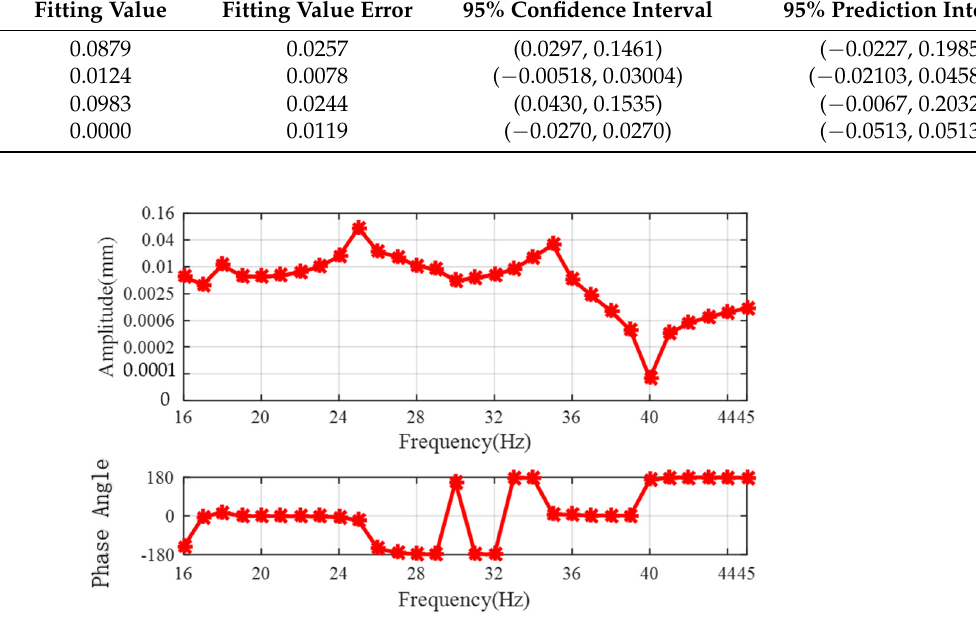
Figure 23. Amplitude response curve of the terminal surface after comprehensive optimization.